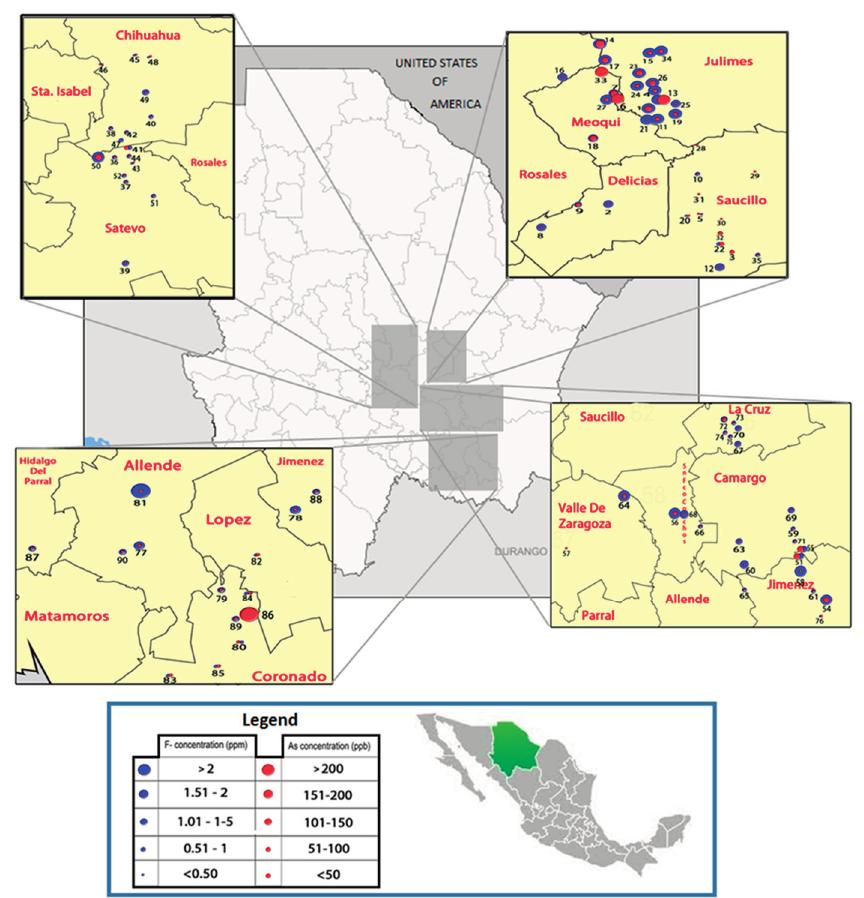
Figure 1. Distribution of arsenic and fluoride concentration in drinking water sources in the study area in Chihuahua, Mexico.